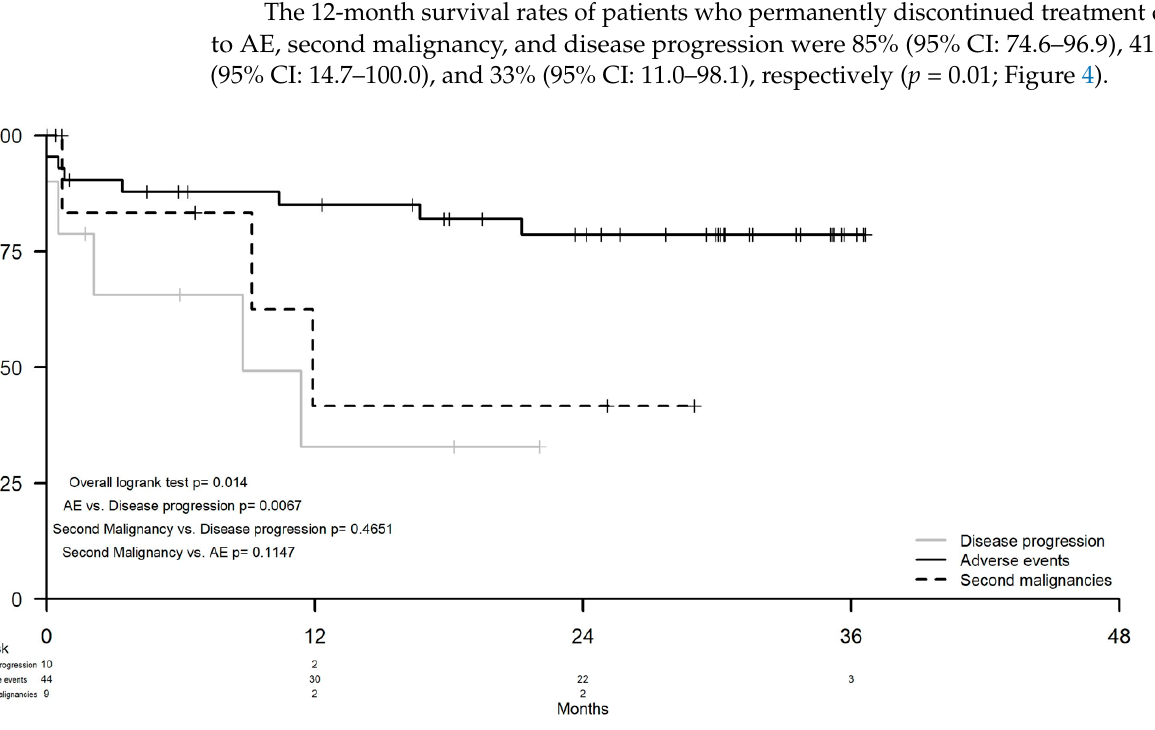
Table 3. Reasons for treatment discontinuation.